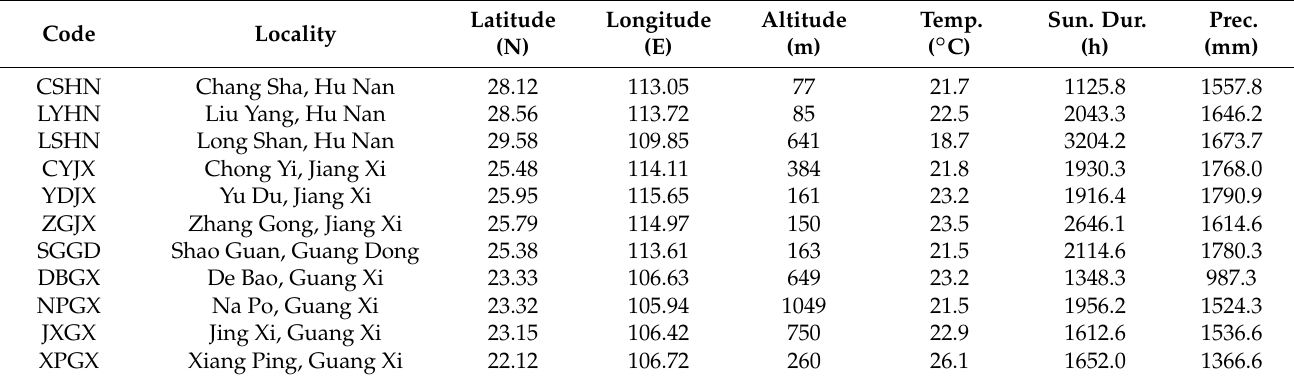
Table 1. Location and climatic conditions of different S. wilsoniana